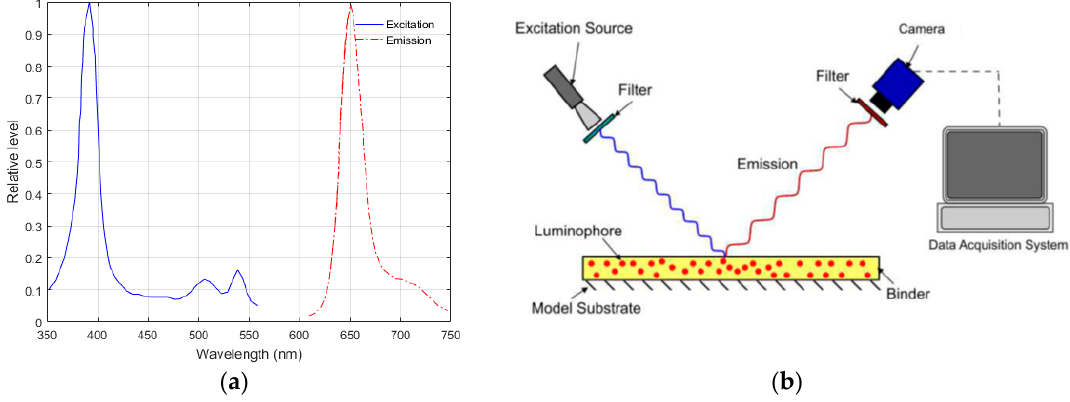
Figure 2. ( a ) Absorption spectra and emission spectra of a PSP containing PtTFPP and ( b ) basic set-up of a PSP system [9].